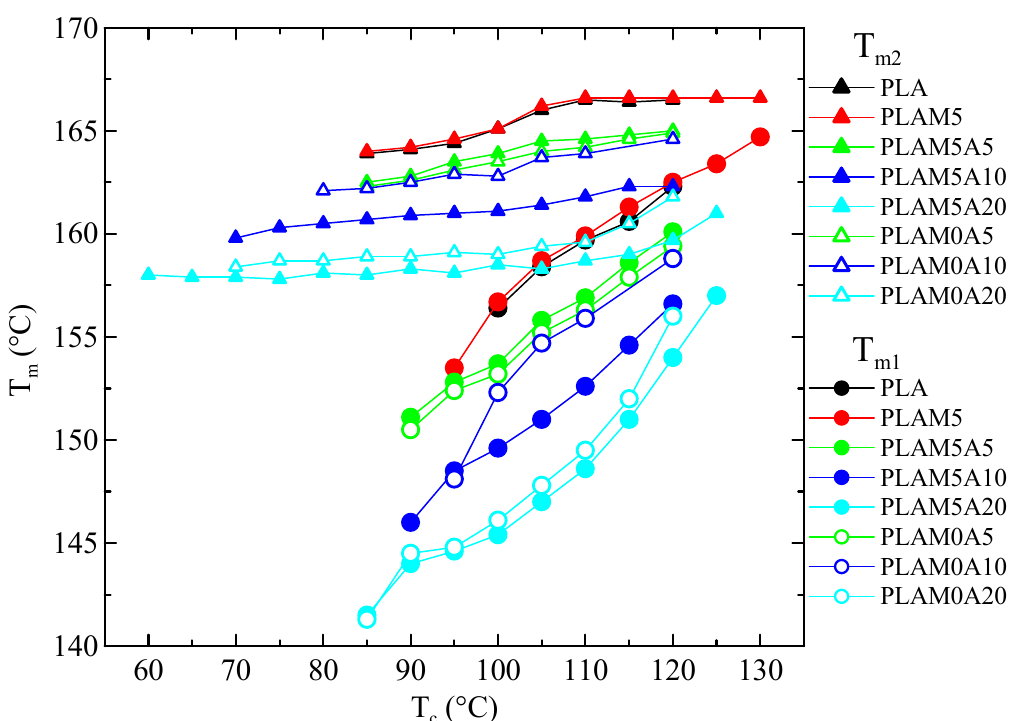
Figure 12. Variation with T c of the melting temperatures for the different samples, when crystallizing from the melt: T m1 (circles) and T m2 (triangles).